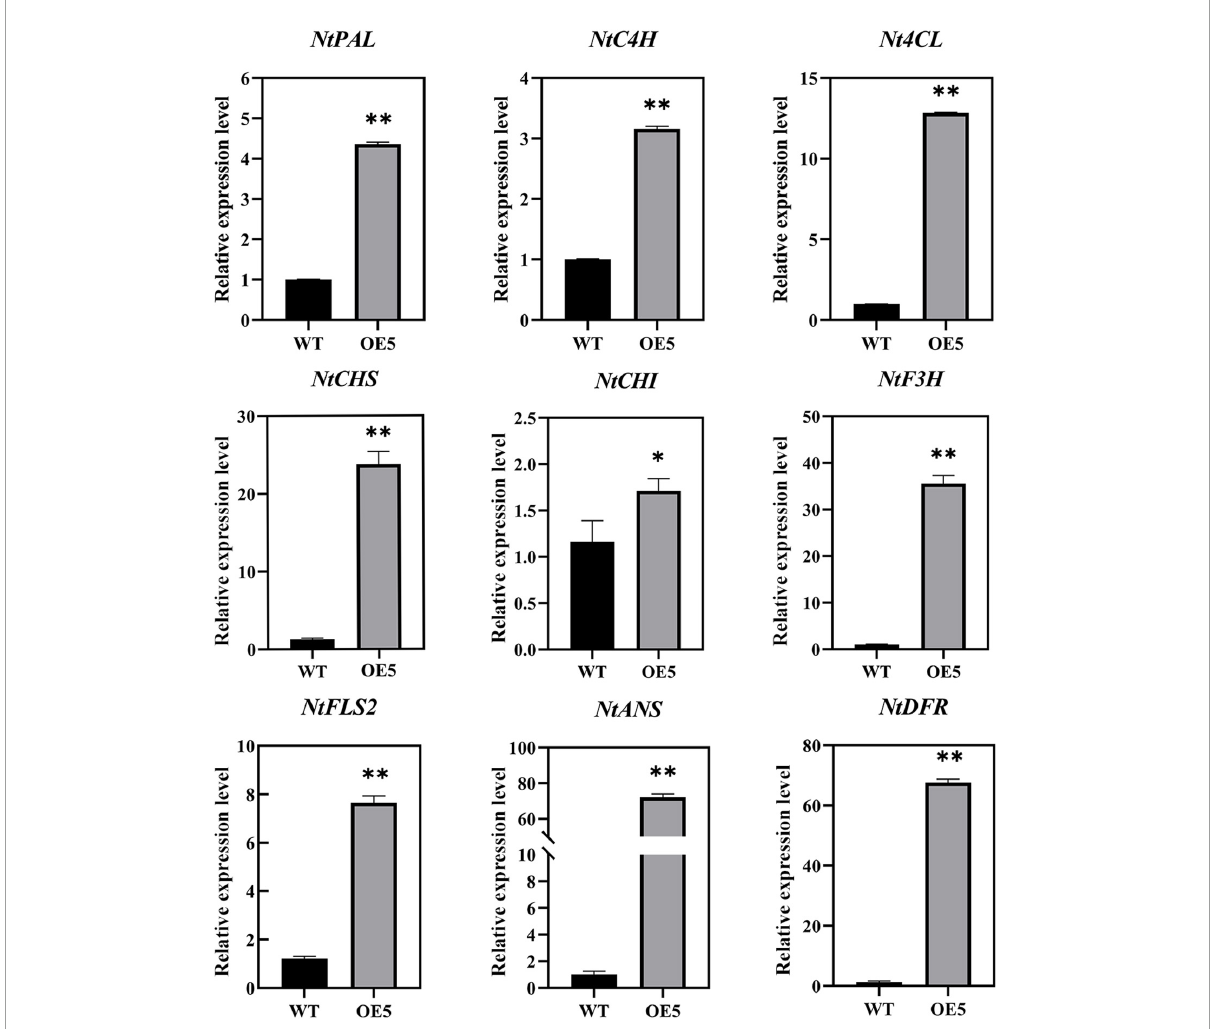
FIGURE9 Expression analysis of flavonoid biosynthesis genes between WT and OE5. The characters on the X -axis indicate the WT and OE5. The Y -axis represents the relative level of gene expression. Data represent mean ± SD of three biological replicates and the one-way analysis of variance was used for statistical analysis ( ∗ P < 0.05; ∗∗ P <